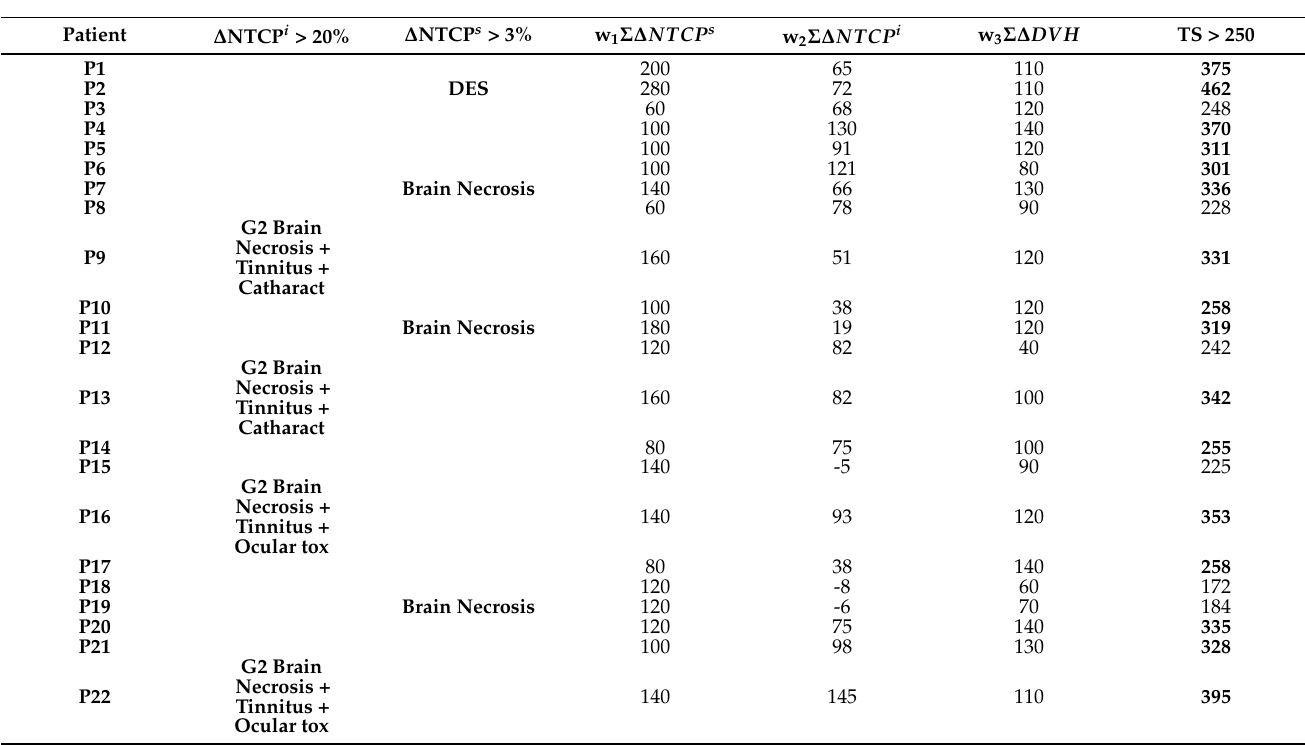
Table 7. Results for selection criteria evaluation. Values in bold character indicate patient cases fulfilling the selected condition criteria. Columns 4–6 show results for each single term in Equation (1), while the TS values are listed in the last